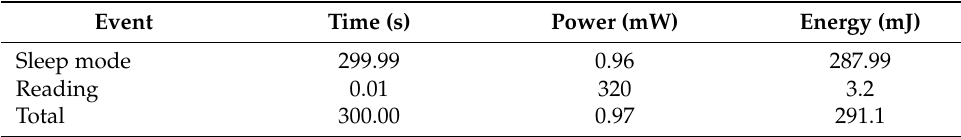
Table 1. Energy consumed by each sensor.